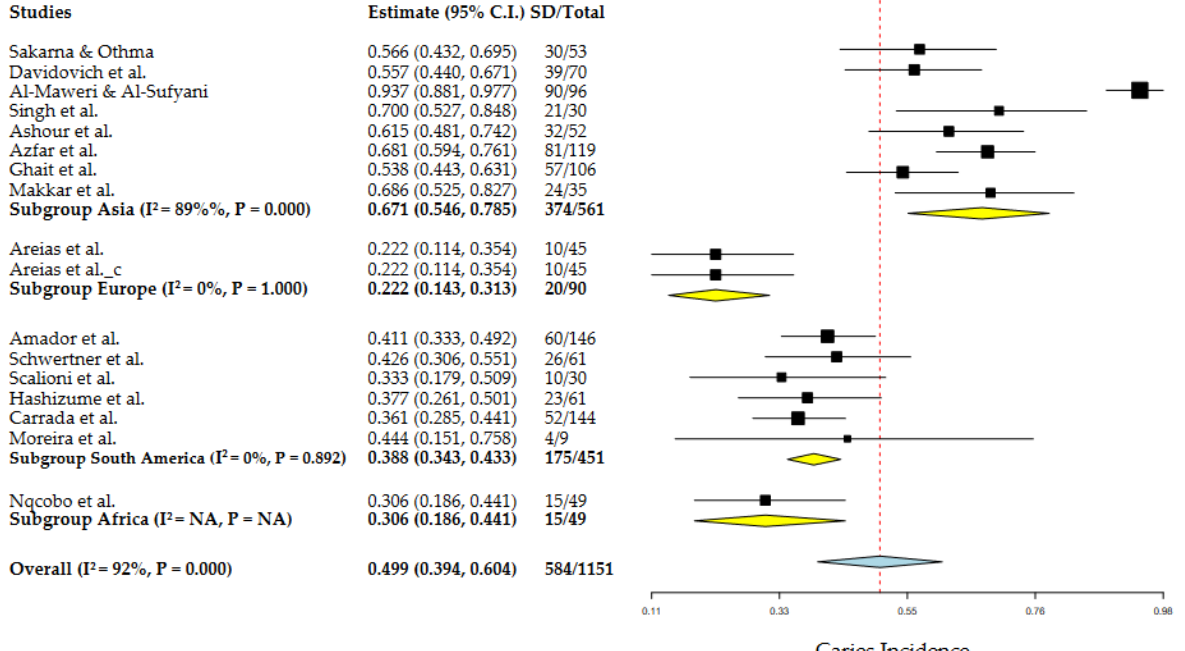
Figure 7. Meta- regression of DMFT versus caries incidence for the DS group . Figure 8. Meta-regression of dmft versus caries incidence for the DS group.